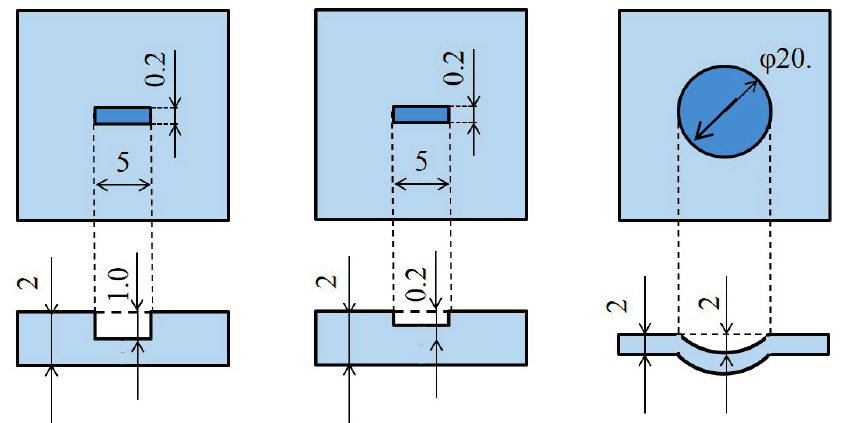
Figure 3. Three kinds of surface damages.